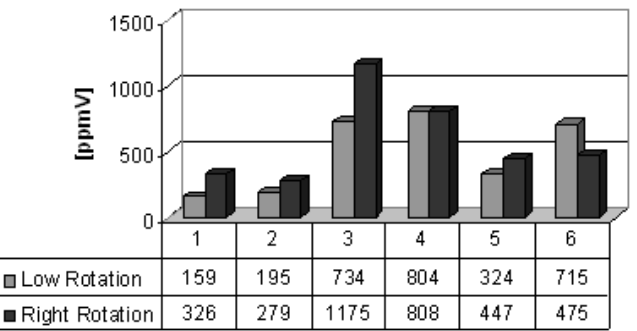
Figure 8. Carbon monoxide concentrations